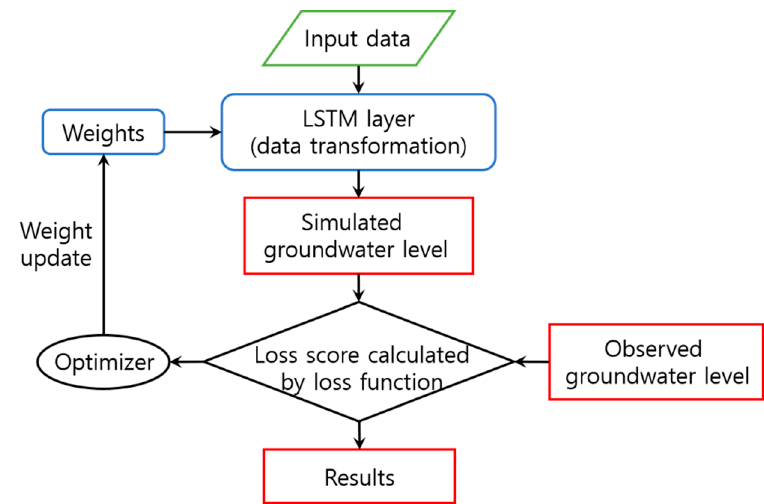
Figure 5. LSTM modeling process. Reproduced from Chollet and Allaire [26].